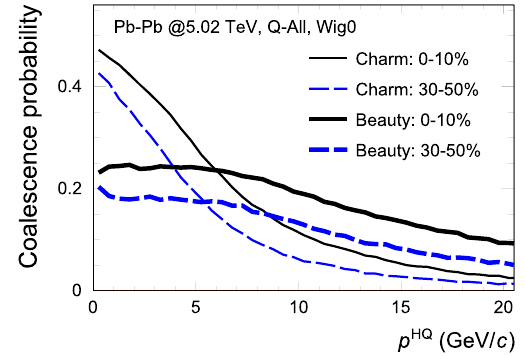
Fig. 1 Comparison of the coalescence probability, for c ¯ q (thin curves) and b ¯ q combinations (thick curves) in central 0 − 10% (solid black curves) and semi-central 30 − 50% (long dashed blue curves) Pb–Pb √ s NN = 5 . 02 TeV, to form the D ( c ¯ q ) and B mesons ( b ¯ q ) collisions at at the ground state